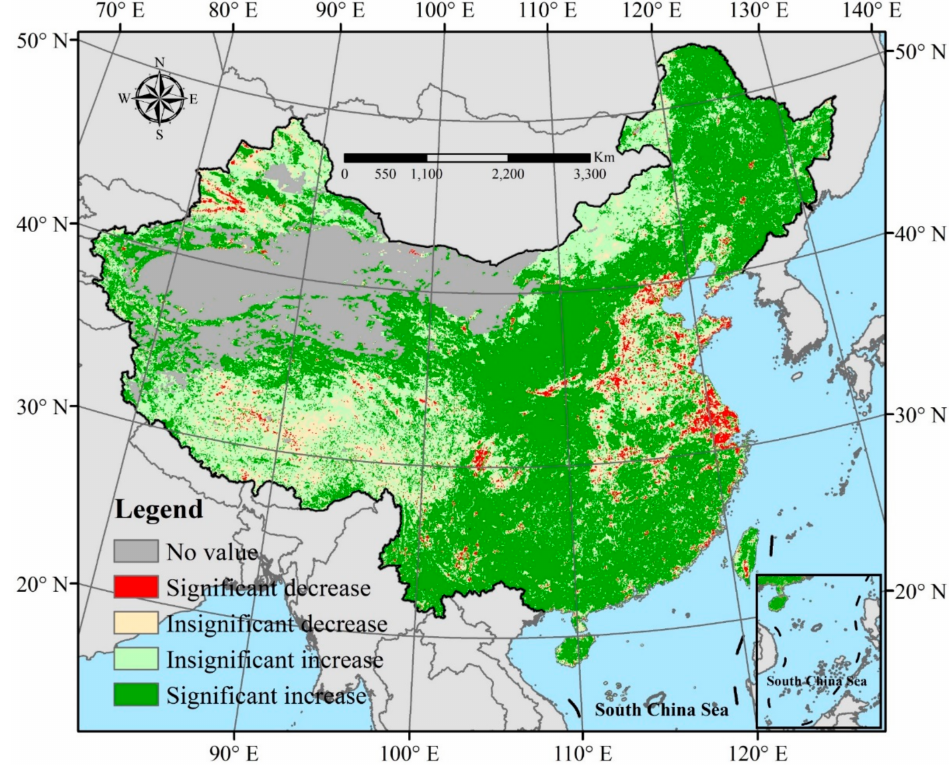
Figure 2. Changes in vegetation cover from 2000 to 2020 based on MODIS.